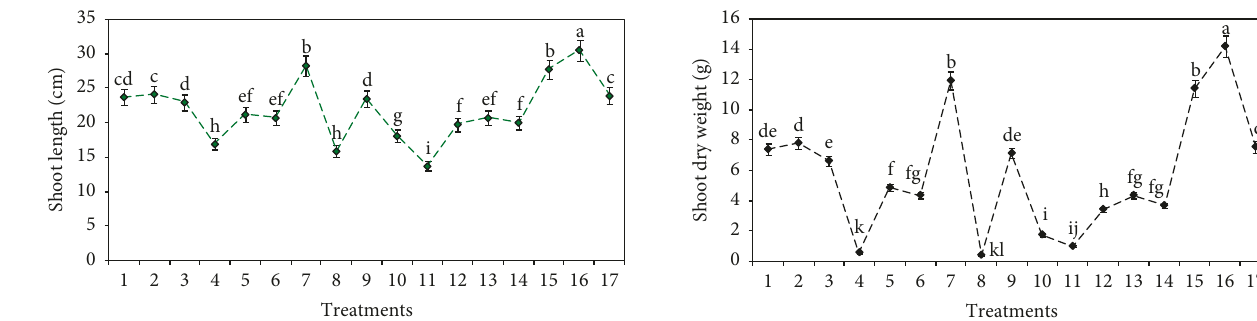
Figure 6: Impact of biosorbed water by various biosorbents (or- ange peels, pomegranate peels, and peanut peels) on the shoot dry weight of mung bean after 7 days of seed germination. T1, negative control; T2, 50mg kg − 1 ; T3, pomegranate peel biosorbed water +50mg kg − 1 ; T4, peanut peel biosorbed water +50mg kg − 1 ; T5, orange peel biosorbed water +50mg kg − 1 ; T6, 100mg kg − 1 ; T7, pomegranate peel biosorbed water +100mg kg − 1 ; T8, peanut peel biosorbed water +100 mg kg − 1 ; T9, orange peel biosorbed water +100 mg kg − 1 ; T10, 150mg kg − 1 ; T11, pomegranate peel biosorbed water +150 mg kg − 1 ; T12, peanut peel biosorbed water +150 mg kg − 1 ; T13, orange peel biosorbed water +150 mg kg − 1 ; T14, 200mg kg − 1 ; T15, pomegranate peel biosorbed water +200 mg kg − 1 ; T16, peanut peel biosorbed water +200 mg kg − 1 ; T17, orange peel biosorbed water +200 mg kg − 1 . Vertical bars (I): standard error (mean of 3 replicates). Alphabets on vertical bars: significant difference ( P ≤ 0 . 05) evaluated by the LSD test.